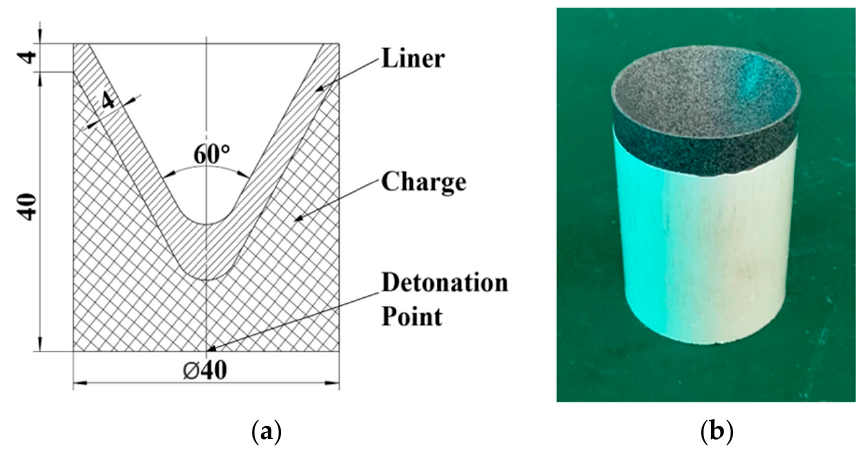
Figure 1. Structure and photograph of shaped charge for X-ray experiment: ( a ) structure and ( b ) photograph. ( b )